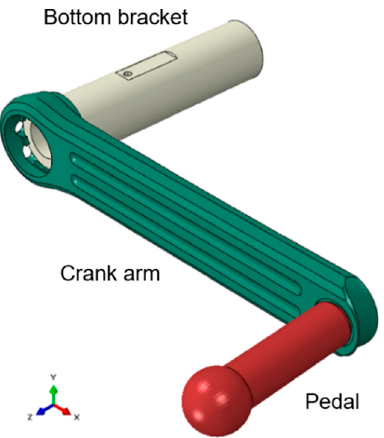
Figure 9. Finite element model of the crank arm assembly.